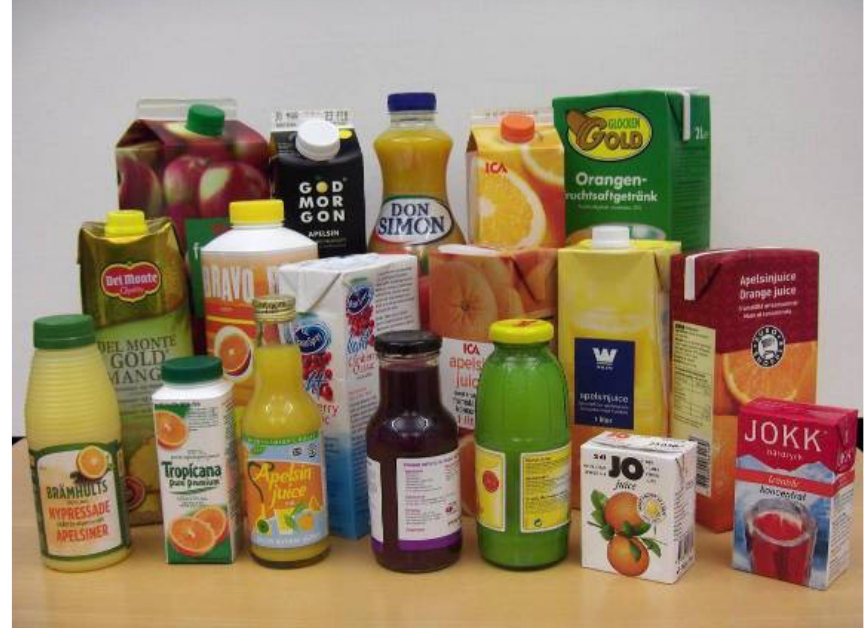
Figure 1. The juice